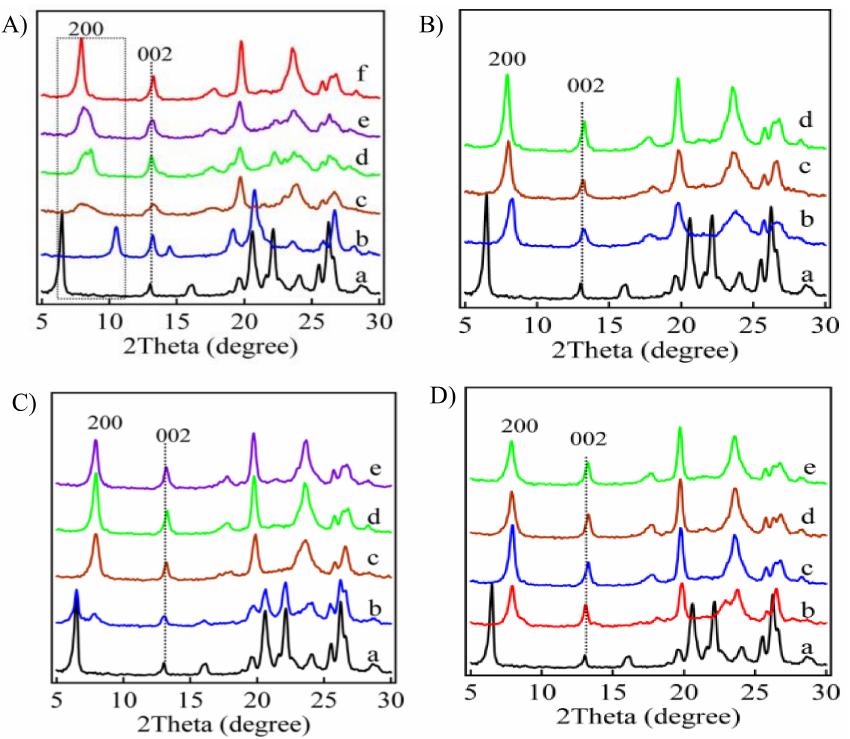
Figure 3. XRD patterns of ( a ) Nu-6(1) precursor (all silica), ( A – b ) NSI sample, and (from A – c to D – e ) IEZ-Nu-6(1) under different conditions. The main conditions consist of 0.5 g Nu-6(1), 0.08 g DEDMS, 473 K, 2 M HCl solution, for a duration of 24 h. ( A ) XRD patterns for various solution compositions: ( A – c ) water, ( A – d ) ethanol/H 2 O (1:1), ( A – e ) ethanol/H 2 O (2:1), ( A – f ) ethanol. ( B ) XRD patterns for various temperatures: ( B – a ) room temperature, ( B – b ) 403 K, ( B – c ) 443 K, ( B – d ) 473 K. ( C ) XRD patterns for various acid concentrations: ( C – b ) 0.5 M HCl, ( C – c ) 1 M HCl, ( C – d ) 2 M HCl, ( C – e ) 3 M HCl. ( D ) XRD patterns for various amounts of DEDMS: ( D – b ) 0 g, ( D – c ) 0.08 g, ( D – d ) 0.13 g, and